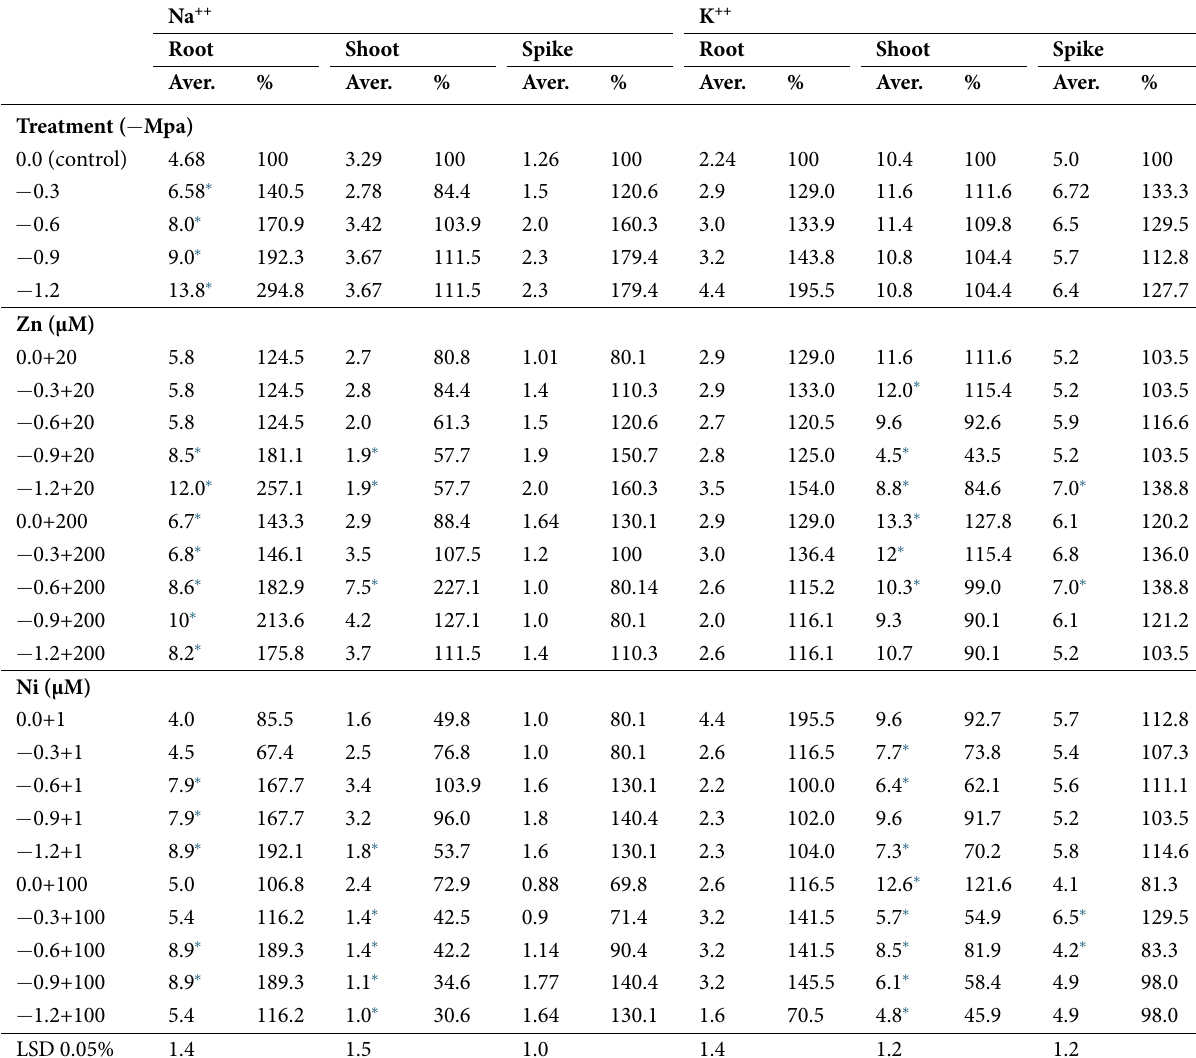
Table 4 Sodium and potassium content (mg/g dry matter) in roots, shoots and spikes of wheat treated by different osmotic stress levels with or without Zn (20 and 200 μM) or Ni (1 and 100 μM)